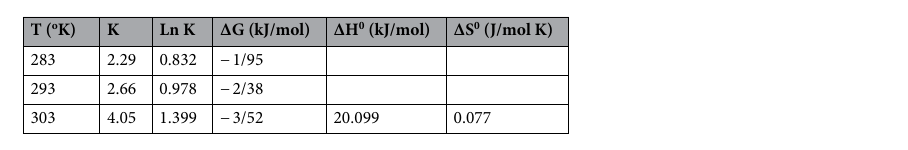
Table 9. Thermodynamic parameters of AR18 adsorption onto the GFH.